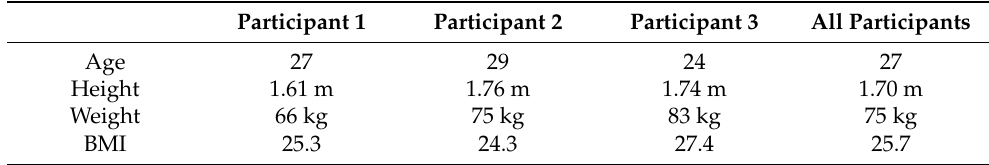
Table 1. Physical characteristics of the participants in the study.